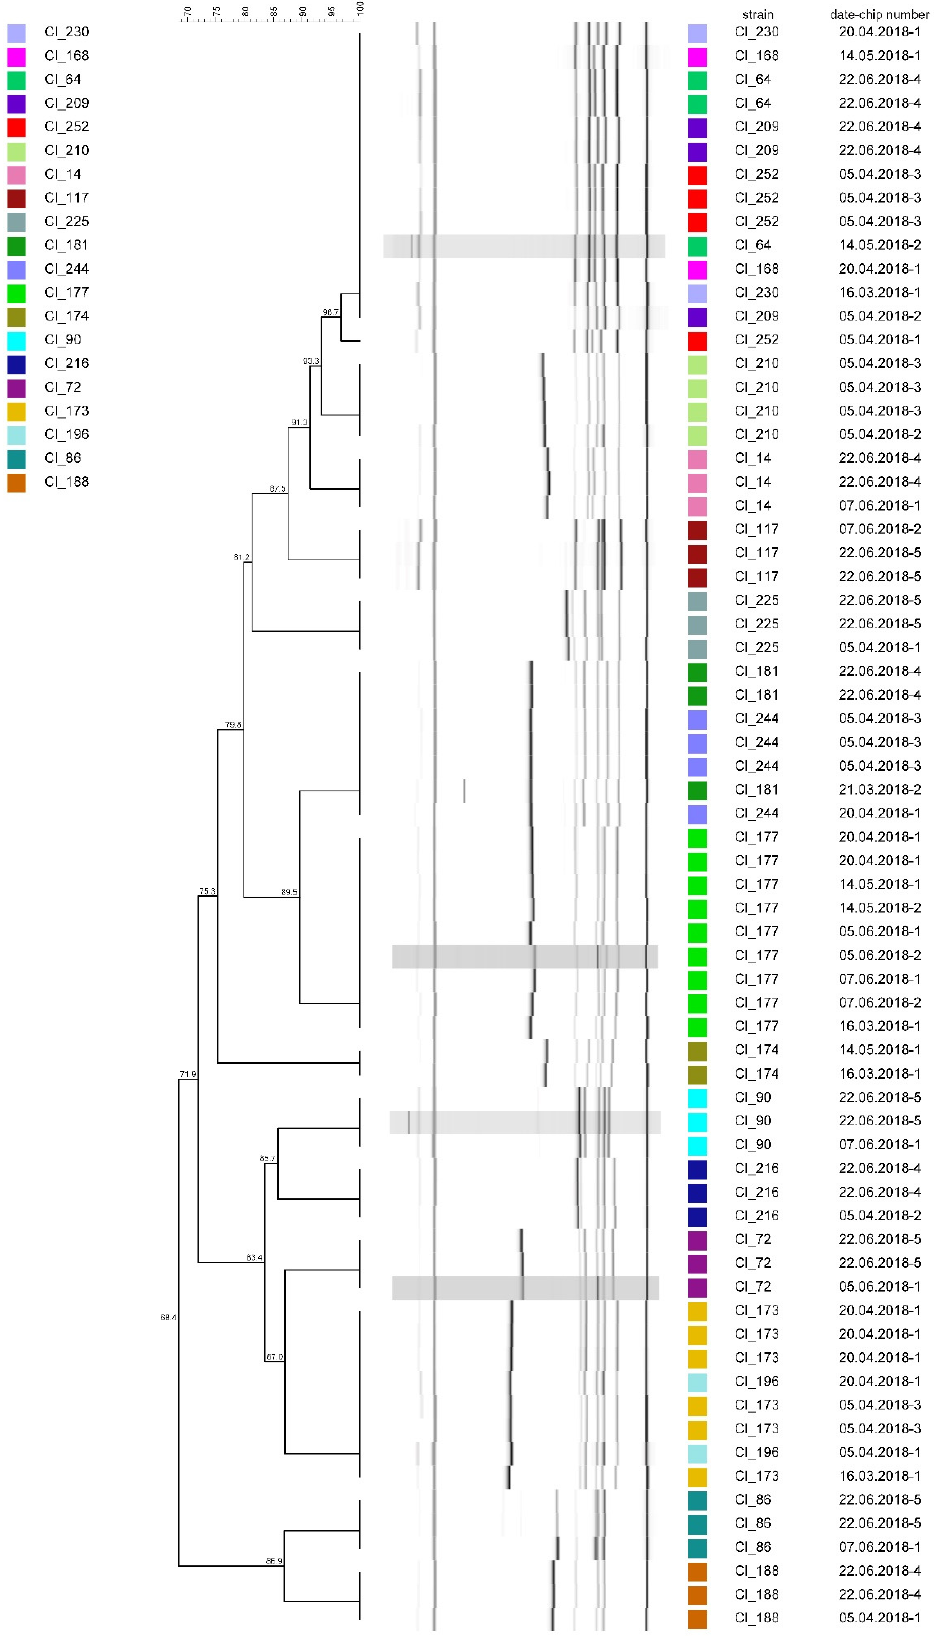
Figure 2. Dendrogram obtained from repeated hexaplex-PCR fingerprinting of 20 C. tyrobutyricum strains. The dendrogram was constructed using the unweighted pair group method with arithmetic mean (UPGMA) with similarity levels expressed as percentage values of Dice’s correlation coefficient.